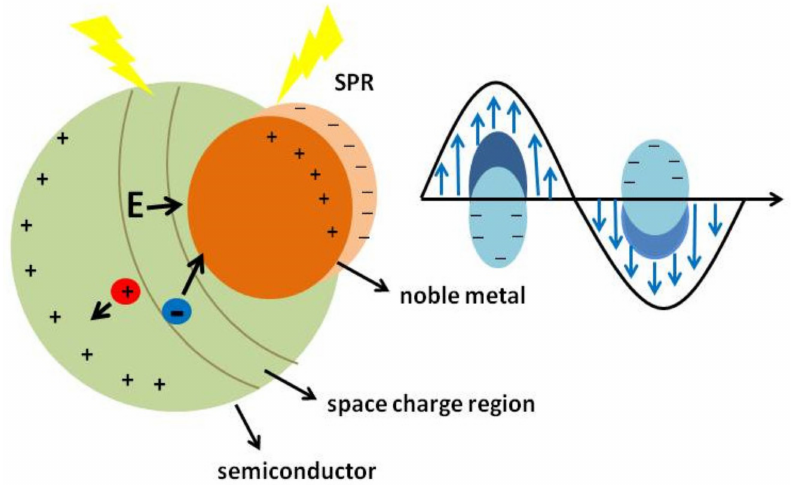
Figure 1. Schematic diagram representing charge separation in Ag/Bi 2 WO 6